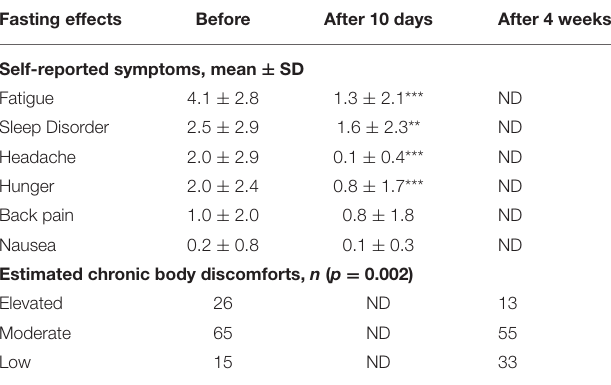
TABLE 4 | Self-reported symptoms before and after 10 fasting days and self-estimated chronic body discomfort before and after 4 weeks of food